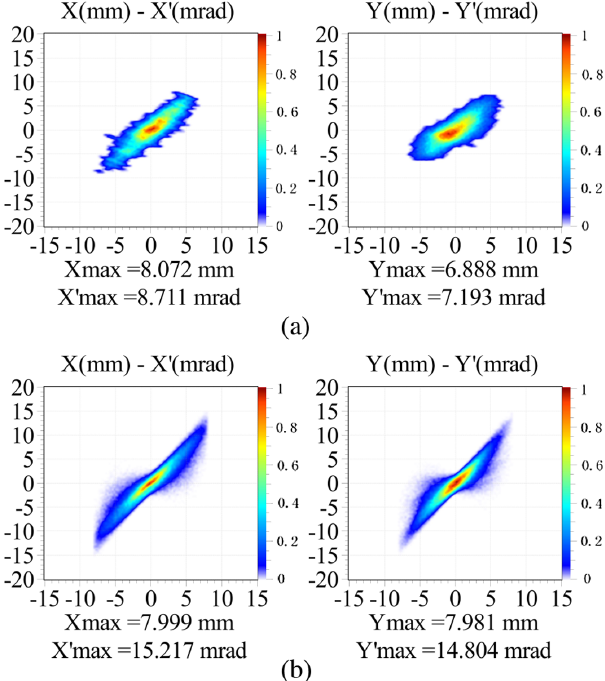
FIG. 16. (a) Measured and (b) simulated phase spaces at the exit of the IH-DTL: horizontal on the left; vertical on the